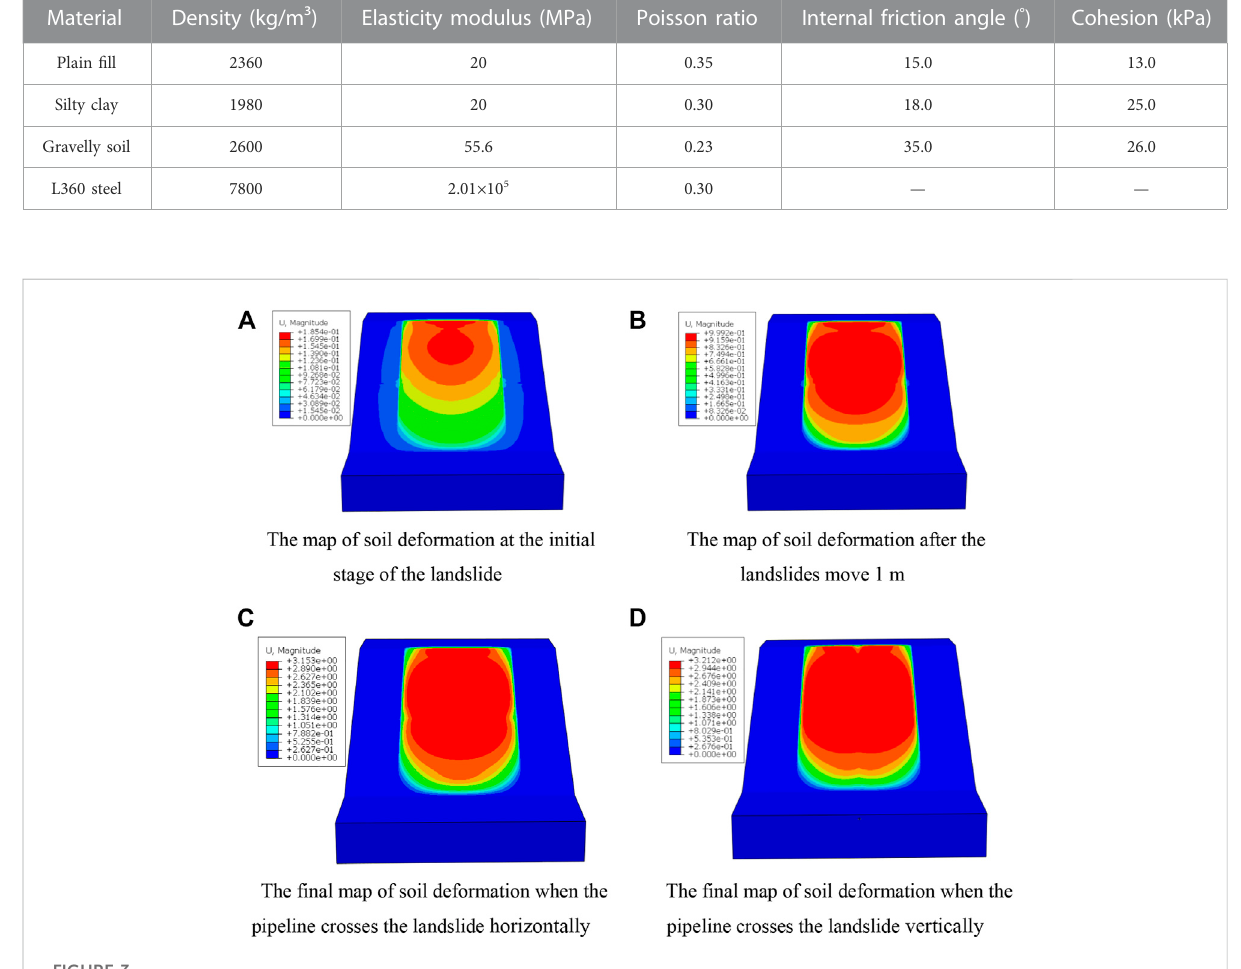
Landslide soil displacement and deformation map. (A) Map of soil deformation at the initial stage of the landslide. (B) Map of soil deformation afterthelandslidesmove1 m. (C) Finalmapofsoildeformationwhenthepipelinecrossesthelandslidehorizontally. (D) Finalmapofsoildeformation when the pipeline crosses the landslide